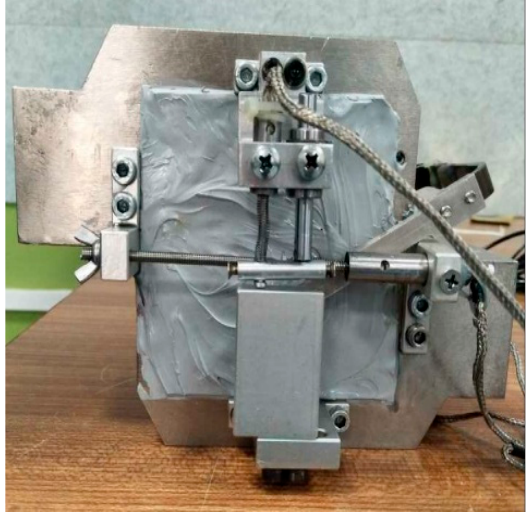
Figure 5. The sealed specimen prepared for the test.